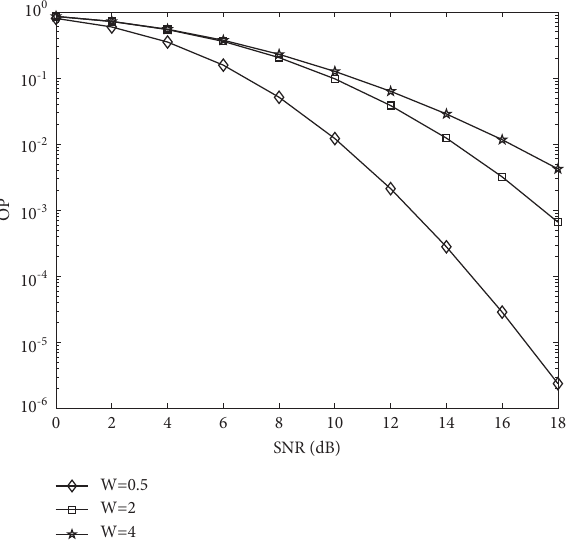
Figure 4: The OP performance with different ( W ) . Table 2: Simulation parameters for Figures 3–6.